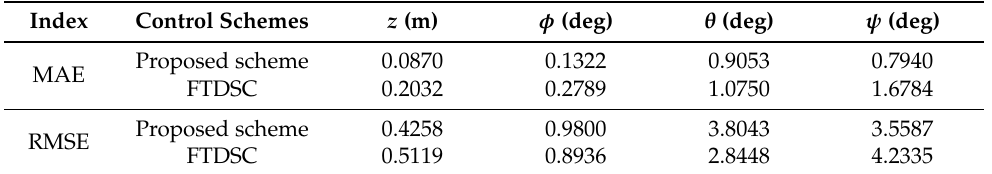
Table 1. Trajectory tracking performance evaluation.